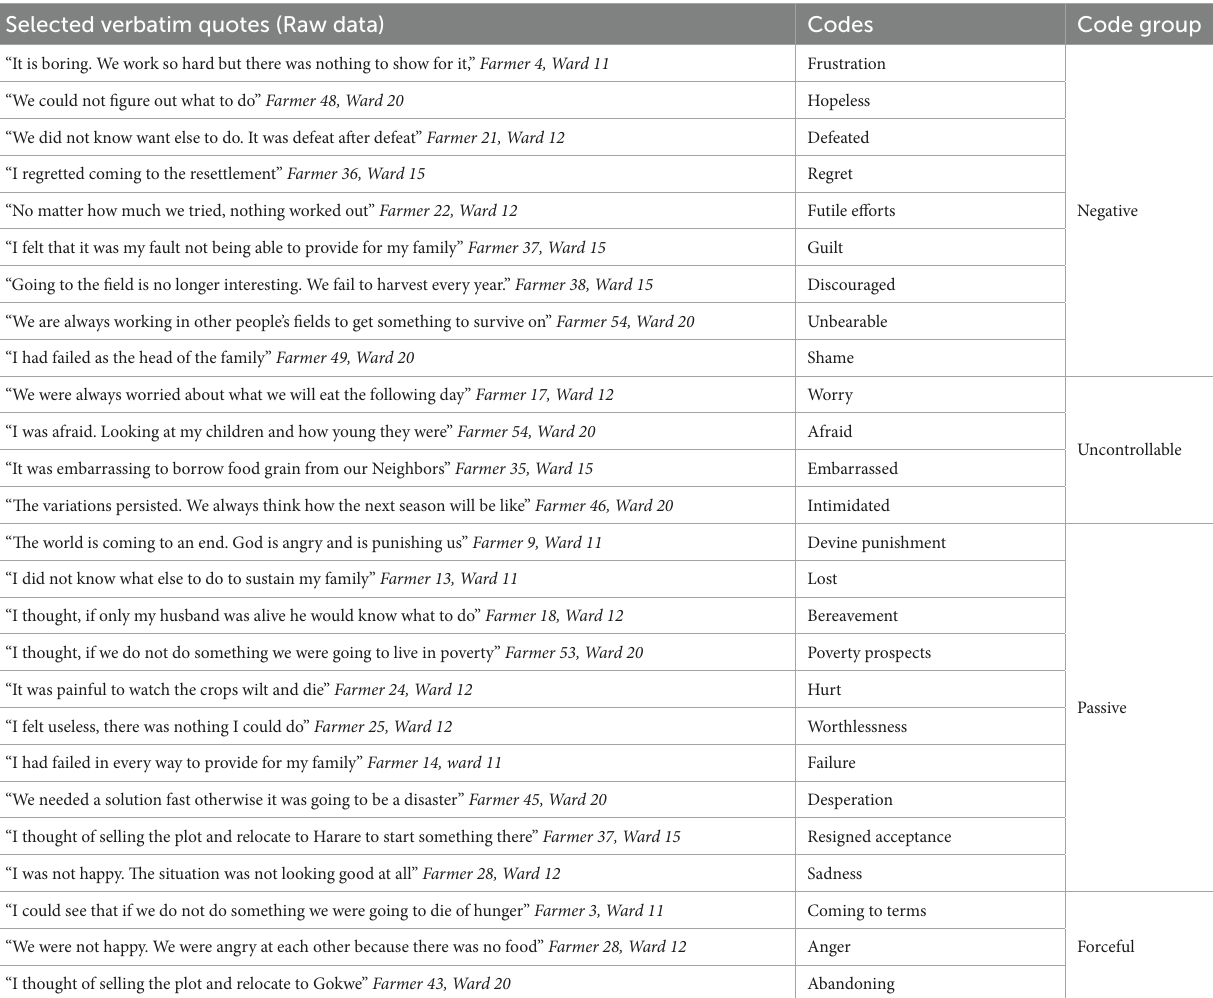
TABLE 1 Psychological impact of climate change on smallholder farmers. Selected verbatim quotes (Raw